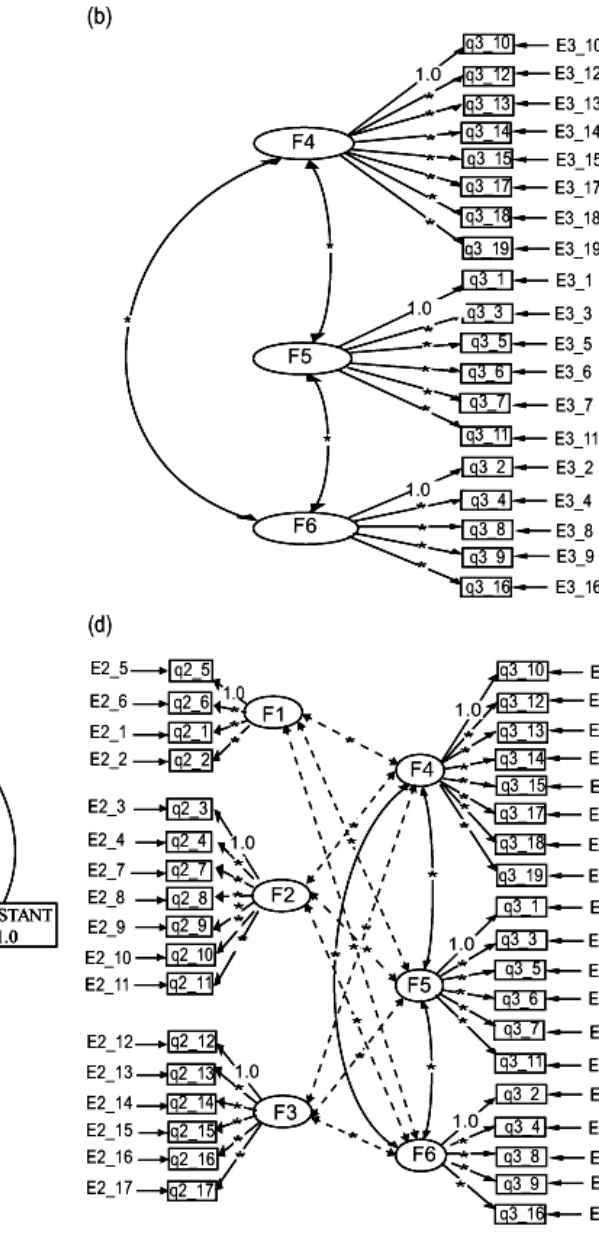
Fig. 2 . Path diagrams for the hypothesized structural equation models for the estimation of (a) factors preventing forest owners from cutting more, i.e., cutting constraints F1, F2, and F3; (b) forest owner representations of forest management, i.e., F4, F5, and F6; (c) differences in factor means between the efficient and inefficient owners, means and covariance structures model (MACS); (d) association between the cutting constraints and the representation of forest management (dotted two-headed arrows). The parameters to be estimated are denoted with an asterisk (*). In each model, one path per factor was fixed to 1 for identification purposes. Measured variables and factors are represented by squares and ellipses, respectively. Regression-like error terms are represented with E. Disturbance terms for factors in MACS are represented with D. Single-headed arrows indicate the hypothesized causal relationship between two variables; two-headed arrows indicate correlation. The explanation of other symbols in MACS is provided in